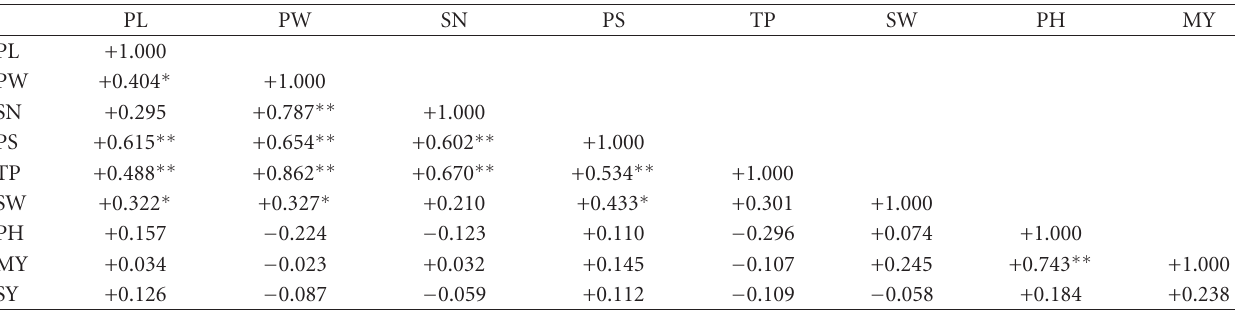
Table 2: Matrix of correlation between agronomic characters.